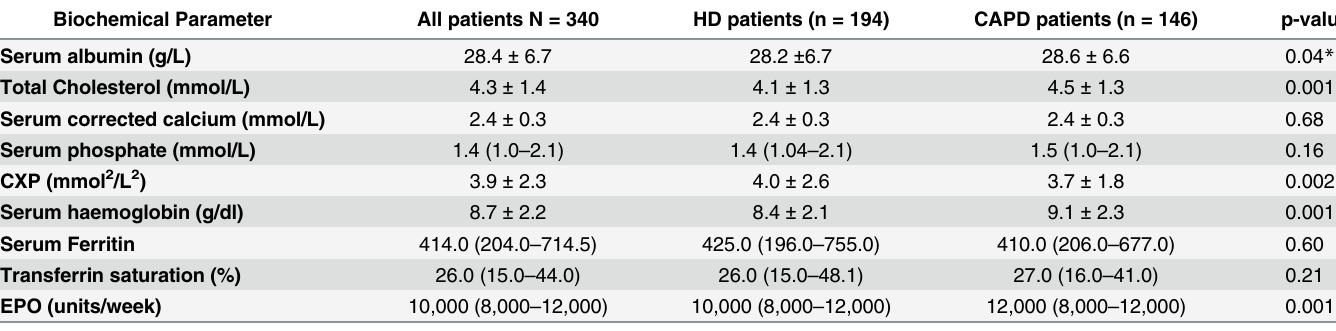
Table 2. Baseline biochemical parameters of patients according to dialysis